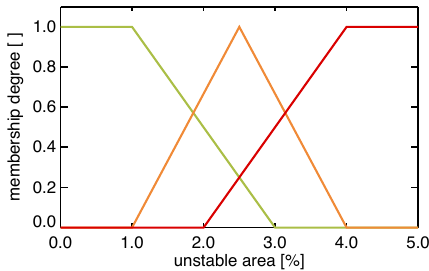
Figure 8. Membership function for the unstable area used in the assessment of the magnitude of the rainfall event. The green, orange and red lines correspond, respectively, to the membership functions for the classes “weak”, “moderate” and “severe” rainfall